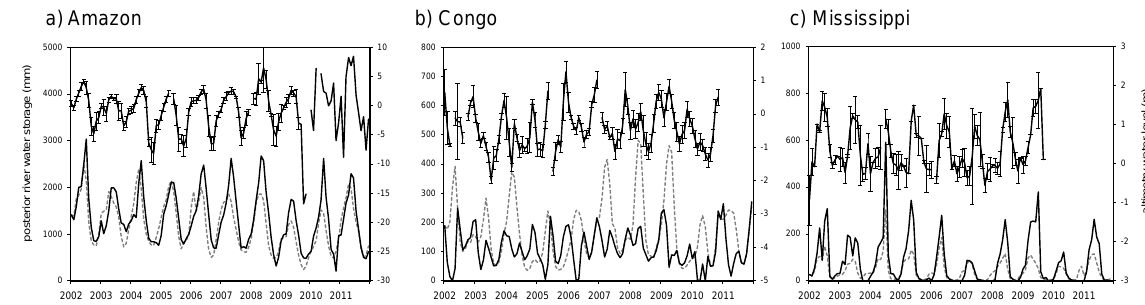
Figure 8. Effect of assimilation on agreement with satellite altimetry river water levels (line with error bars) for selected grid cells, including the (a) Amazon River ( ∼ 2.5 ◦ S, 65.5 ◦ W; ρ changed from 0.71 for prior (dashed) to 0.80 for posterior (solid line) estimates), (b) Congo River ( ∼ 2.5 ∼ N, 21.5 ◦ E; ρ from 0.28 to 0.47) and (b) Mississippi River (35.5 ◦ , 90.5 ◦ W; ρ from 0.37 to 0.56).